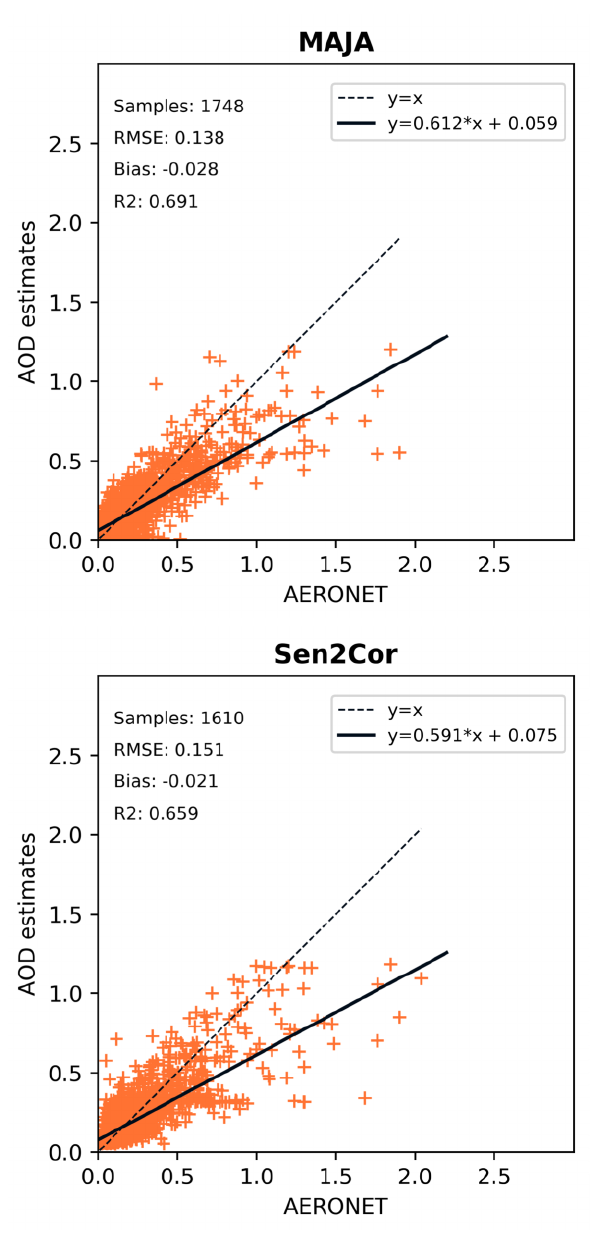
Figure 3. Validation of AOD retrievals for 2 operational Level-2A atmospheric correction methods, results are